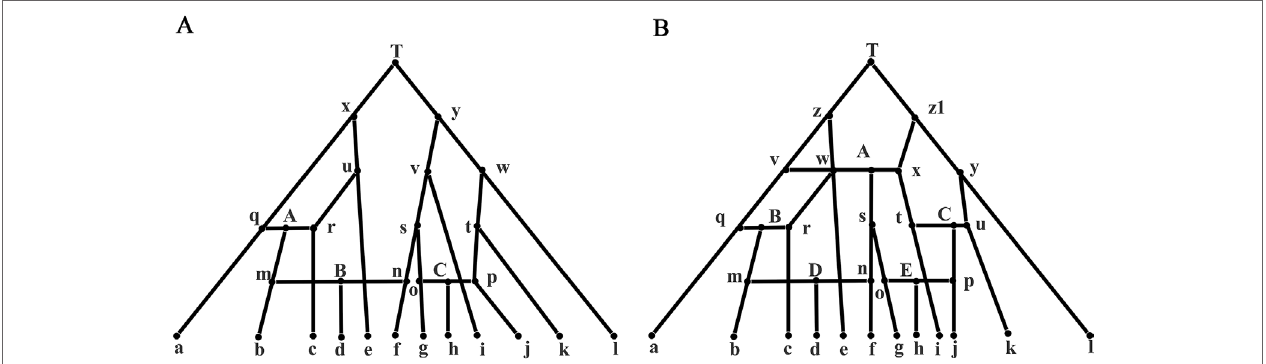
FIGURE 2 | Phylogenetic network with 3/5 reticulate events. (A) A phylogenetic network with three reticulate events A, B, and C. (B) A phylogenetic network with five reticulate events A, B, C, D, and